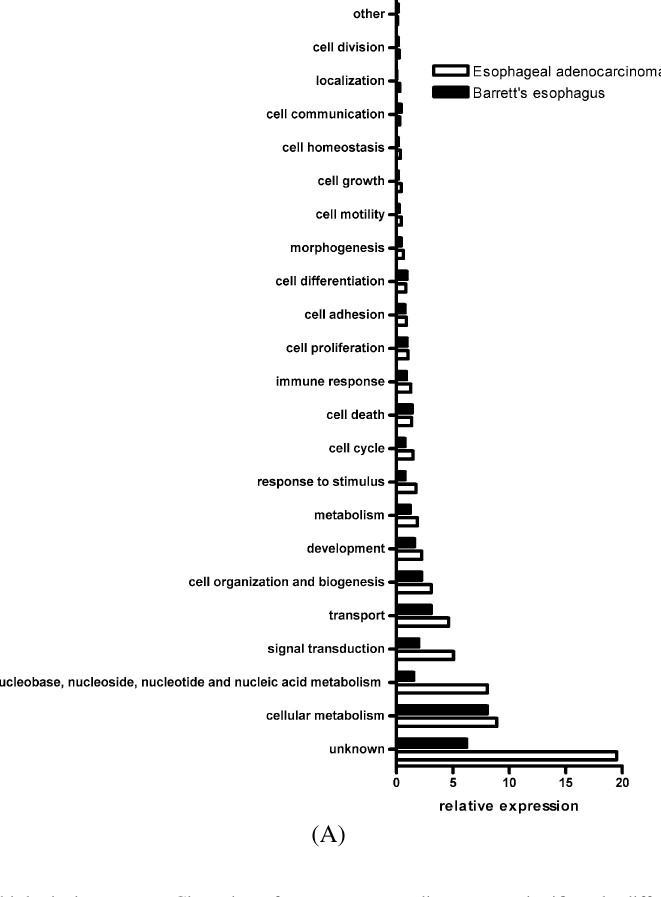
Fig. 1. Clustering of genes in biological processes. Clustering of genes corresponding to tags significantly differentially expressed comparing esophageal adenocarcinoma with Barrett’s esophagus in groups of biological processes according to the Gene Ontology of the National Cancer Institute (http://cgap.nci.nih.gov) shows that genes in the clusters nucleobase/nucleoside/nucleotide and nucleic acid metabolism, cell growth, response to stimulus and signal transduction are predominantly expressed in esophageal adenocarcinoma (A). Genes in the clusters cell commu- nication and cell differentiation are more expressed in Barrett’s esophagus (A). Clustering of genes corresponding to tags significantly differen- tially expressed comparing esophageal squamous cell carcinoma with normal squamous esophagus shows that genes in the clusters cell cycle, metabolism, signal transduction, immune response and cell growth are more abundantly expressed in esophageal squamous cell carcinoma (B). Only genes in the cluster cell–cell signaling were predominantly expressed in normal squamous epithelium